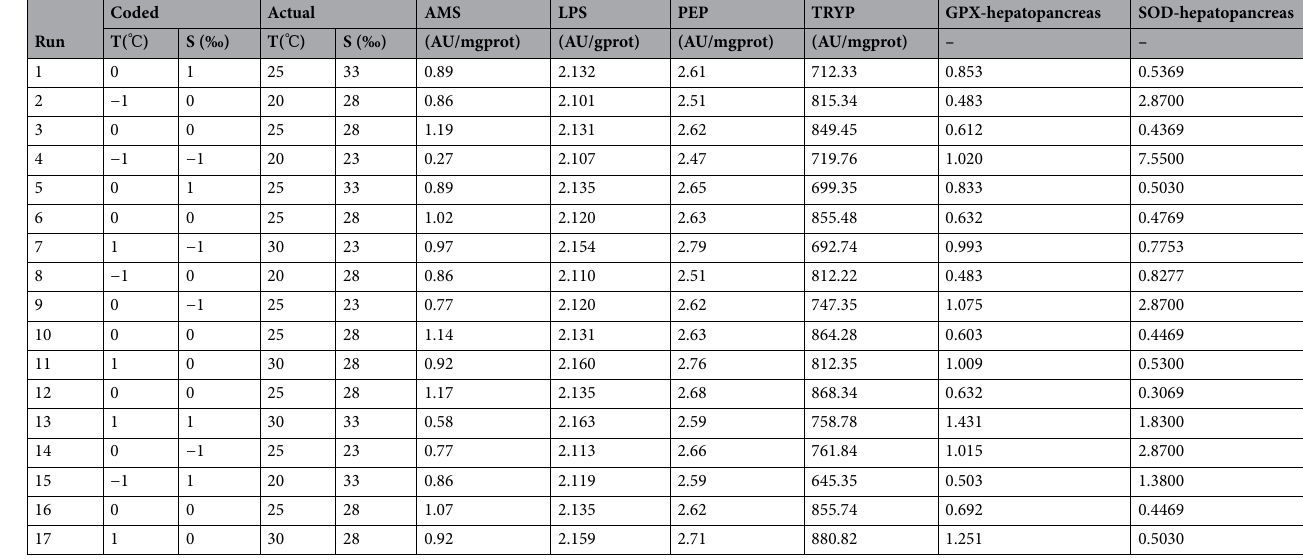
Table 6. Experimental design and results of digestive response surface.